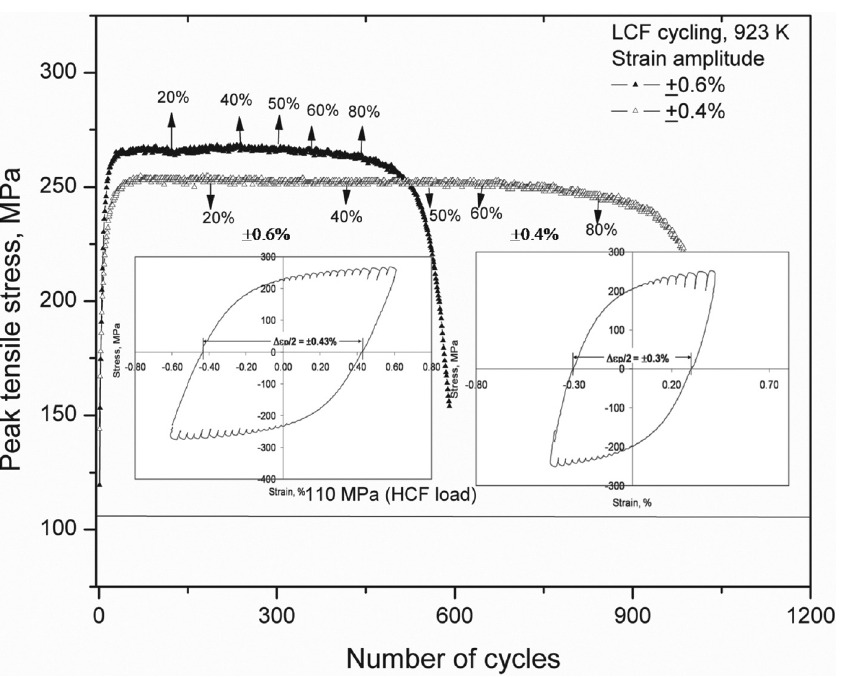
Fig. 1: Cyclic stress response (CSR) curve for 316LN SS at 923 K at the strain amplitudes of ± 0.6% and ± 0.4%. Inset gives the half-life hysteresis loops pertaining to the above strain